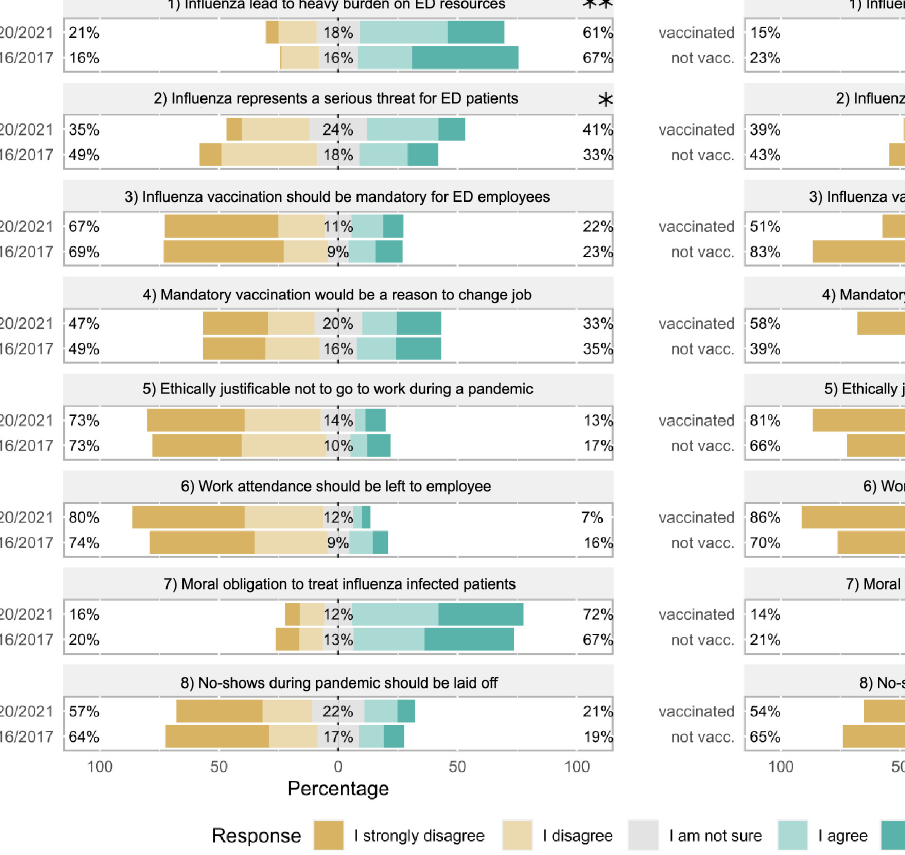
Fig 4. Comparison of views on the burden of influenza in the EDs and ethical attitude of employees towards vaccination and work attendance. Acceptance of statements on the impact of influenza on EDs and various ethical issues related to influenza (vaccination) or work attendance assessed on a 5-Point Likert scale was compared between the seasons 2016/2017 and 2020/2021 (left) or between vaccinated and not vaccinated respondents in 2020/2021 (right). Statistics were performed after conversion of ordinal answer levels to a numeric scale using Mann-Whitney U tests, p-values are depicted as � < 0.05, �� < 0.01 and ��� < 0.001.